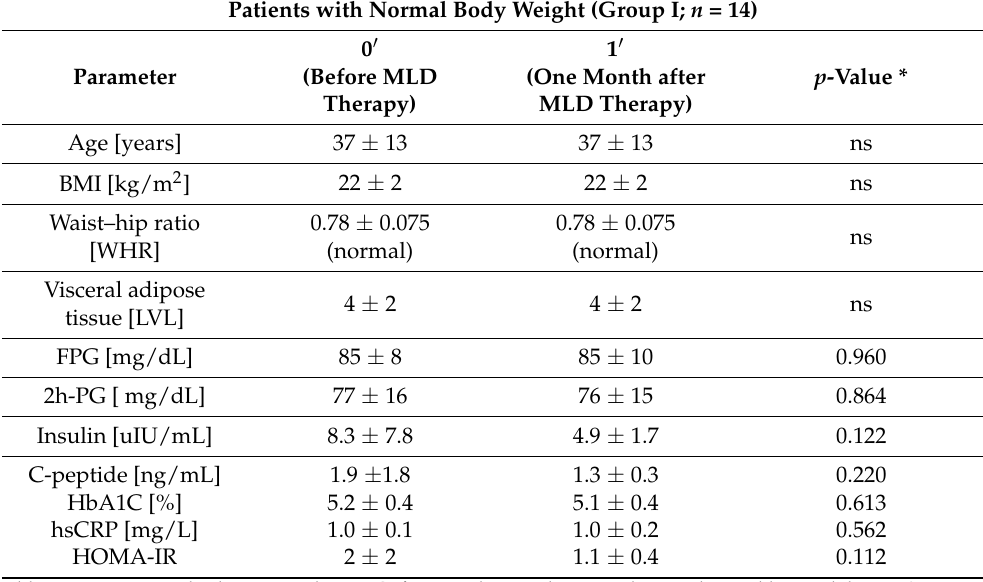
Table 3. Biochemical and anthropometric parameters before and after MLD therapy in patients with normal body weight as a control group (group I). Data are presented as mean values and their standard deviations; * p -value for the comparison before and one month after MLD therapy.